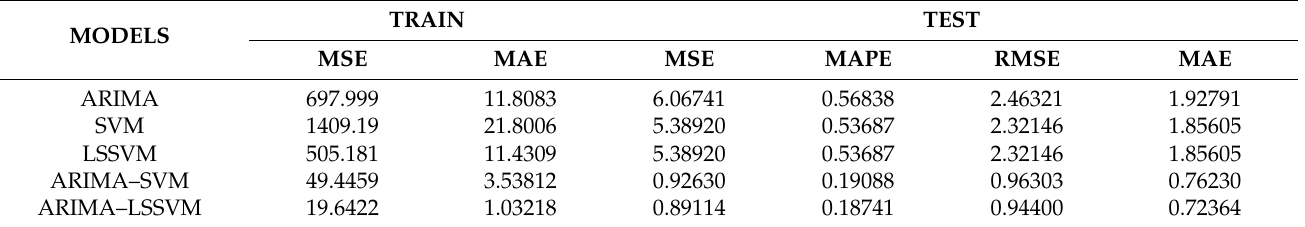
Table 7. Performance measures of the proposed model for daily new deaths COVID-19 cases